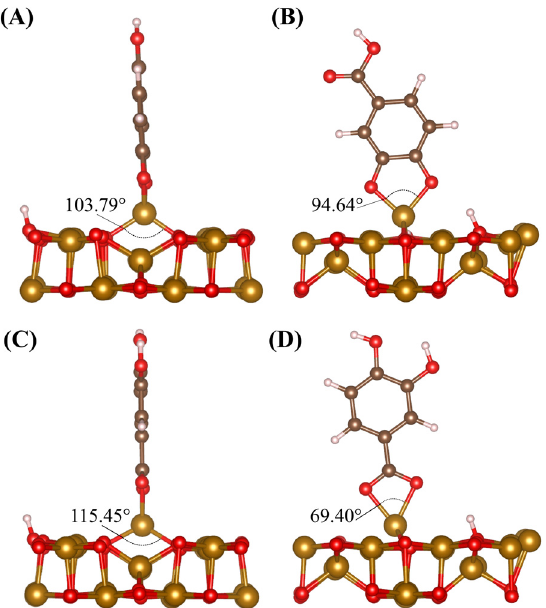
Figure 9. Surface Fe bond angles for ( A ) bottom of DHBA via phenolic OH group adsorption, ( B ) top of DHBA via phenolic OH group adsorption, ( C ) bottom of DHBA via carboxyl group adsorption, ( D ) top of DHBA via carboxyl group adsorption. Values of bond angles in degrees are shown on each panel.